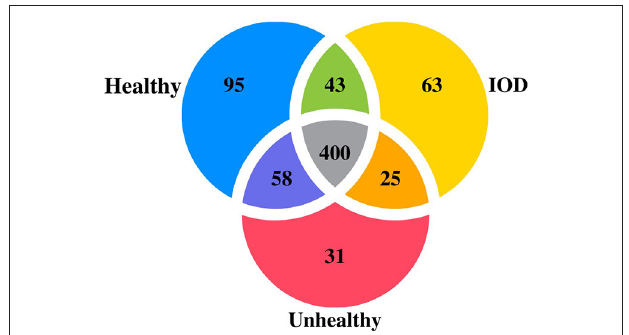
FIGURE 1 | Venn diagram depicting number of microRNAs expressed in serum from healthy ( n = 9), unhealthy ( n = 5) and IOD (n = 4 samples; three individuals) afflicted black ( Diceros bicornis ) and Sumatran ( Dicerorhinus sumatrensis ) rhinos.